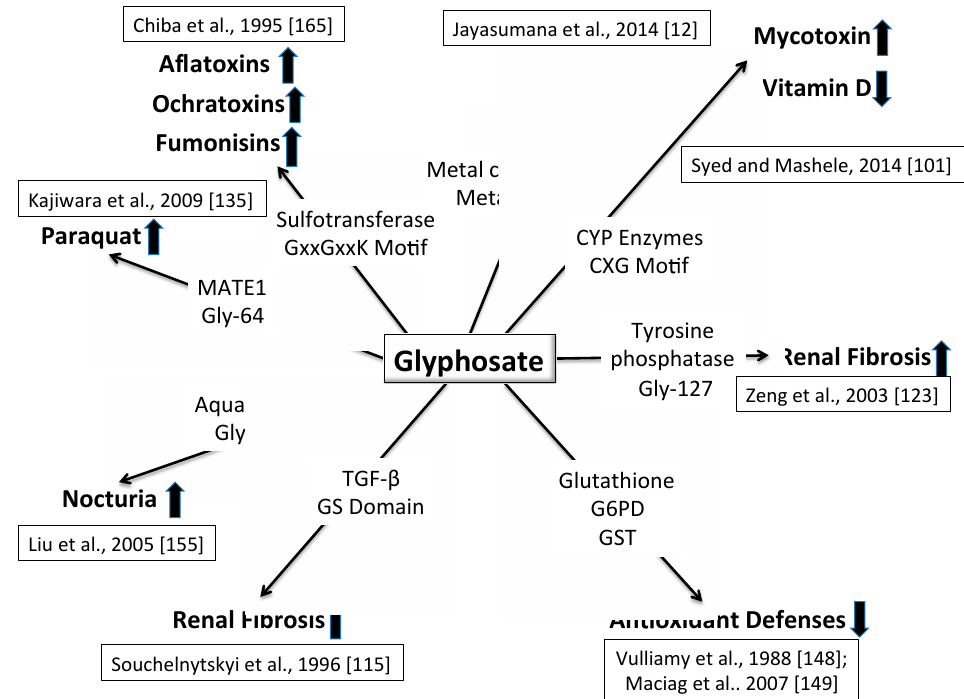
Figure 5. Schematic of multiple ways that glyphosate could cause kidney disease, working in concert with multiple other toxic exposures. See text for details.